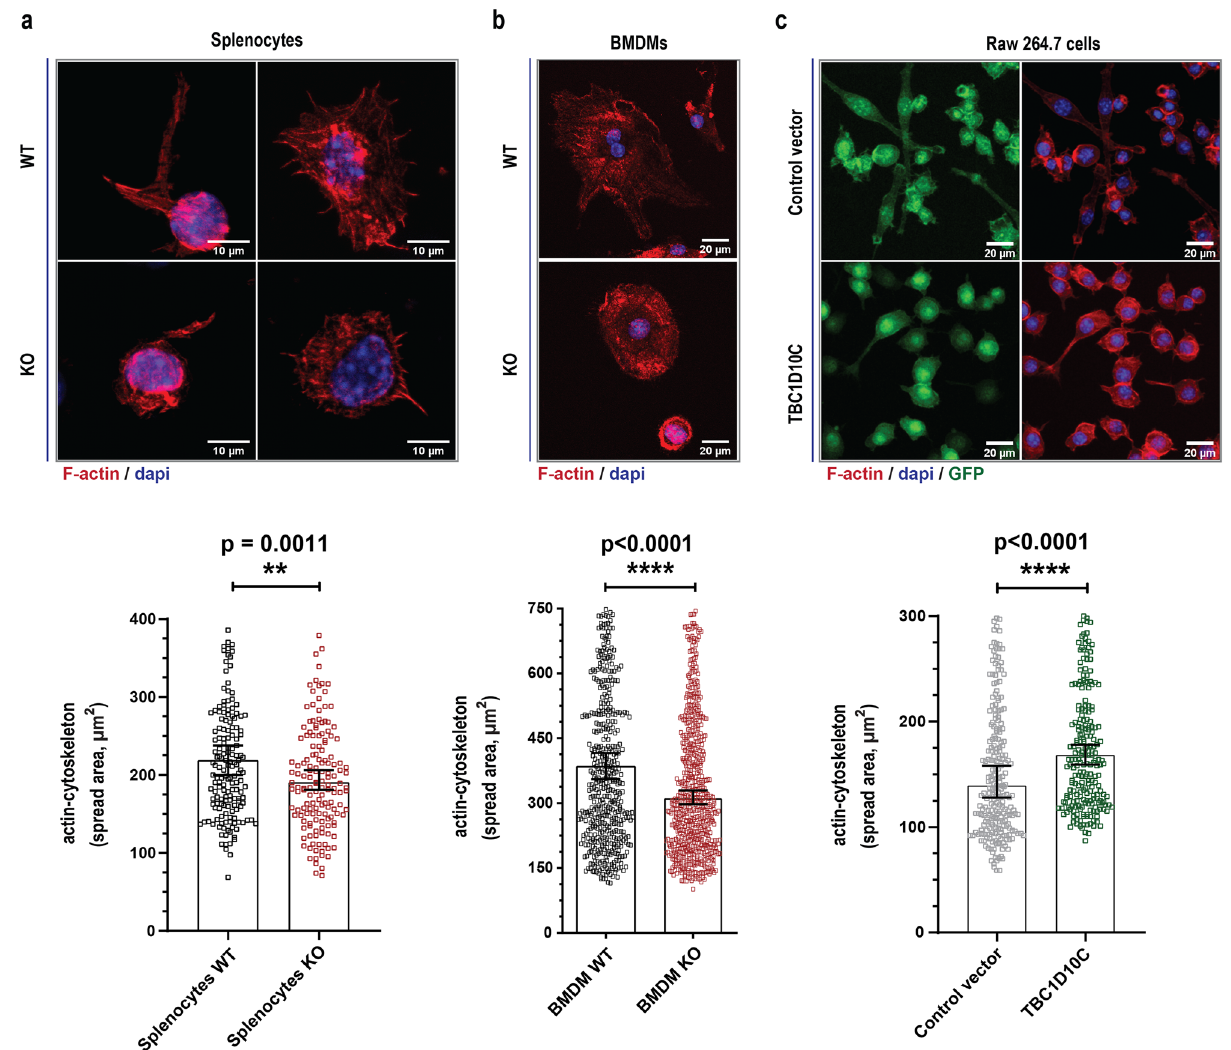
Figure 1. Quantification of cell spreading dependent on actin-cytoskeleton. Cells were stained with phalloidin, and the area of cell spread was calculated. ( a ) top: Confocal images of splenocytes, bottom: corresponding spread area data from confocal images (n = 4, mice; 185 WT, 158 KO cells); ( b ) top: confocal images of BMDM, bottom: corresponding spread area data from confocal images (n = 7 mice; WT BMDM, 572, KO BMDM, 623); ( c ) top: confocal images of Raw 264.7 transfected macrophages, corresponding spread area data from confocal images (254, Control vector and 221, TBC1D10C cells; 2 independent experiments). Confocal images are presented as the sum of slice projections. Data were analyzed by the Mann–Whitney test (P < 0.05), and graphs show SEM (standard error of the